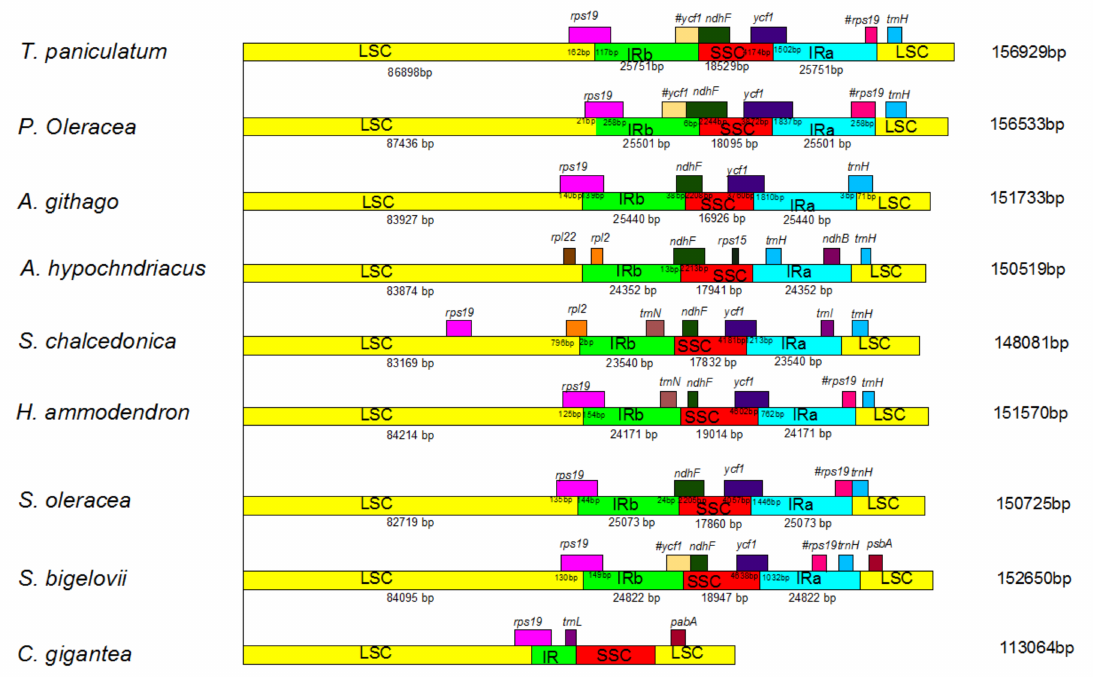
Figure 7. Comparison of the borders of the LSC, SSC and IR regions in nine Caryophyllales species. #indicates that the gene is a